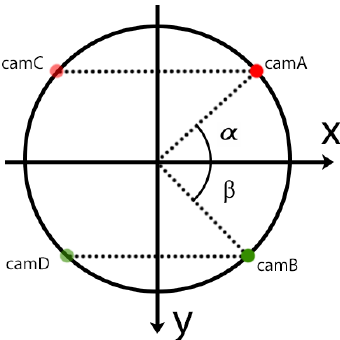
Figure 12. Coordinates defining the position of the cameras on a single ring. Figure 12 . Coordinates defining the position of the cameras on a single ring.